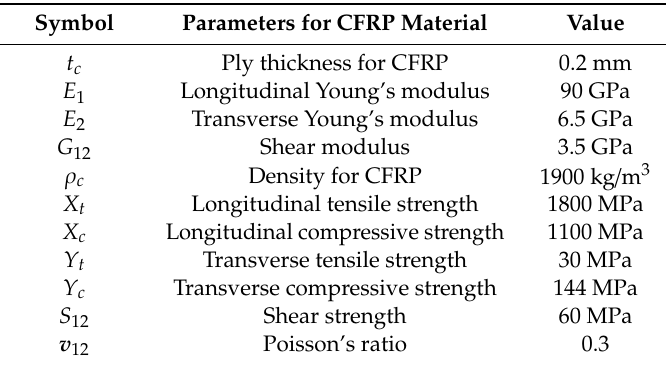
Figure 2. Loading and boundary condition of the finite element model. Table 1. Material parameters of carbon-fiber-reinforced plastic (CFRP).